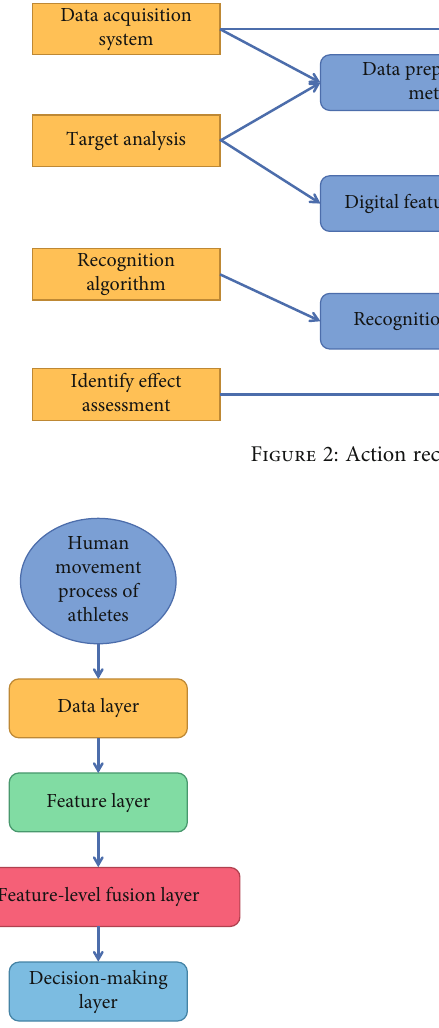
Figure 3: Overall framework of the